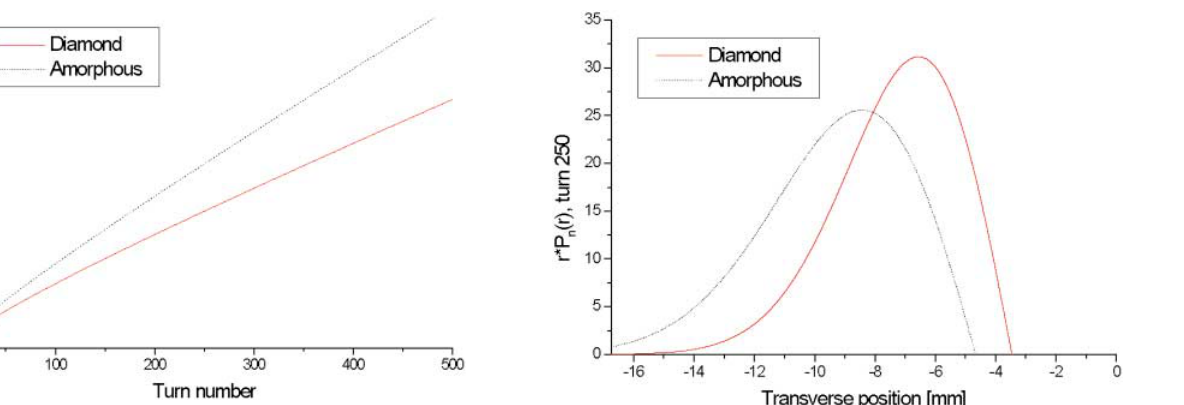
FIG. 8. (Color) The beam density, rP n (cid:3) r (cid:4) , as a function of the horizontal position at turn 250. The solid line is for a diamond, while the dotted line is for an amorphous carbon target, both of 240 m g (cid:2) cm 2 . The scraper is at 2 16.7